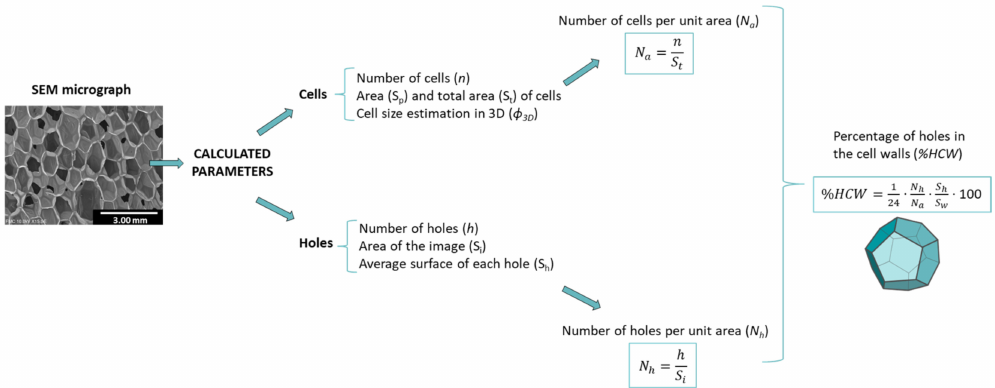
Figure 2. Cellular structure characterization